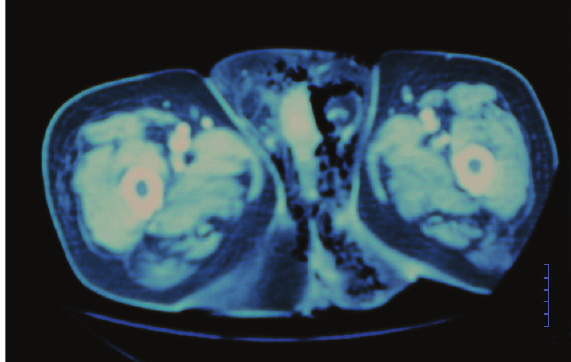
Figure 1: Computed tomography of the pelvis dipecting extensive emphysema around the testicles and perineal subcutaneous tissue.